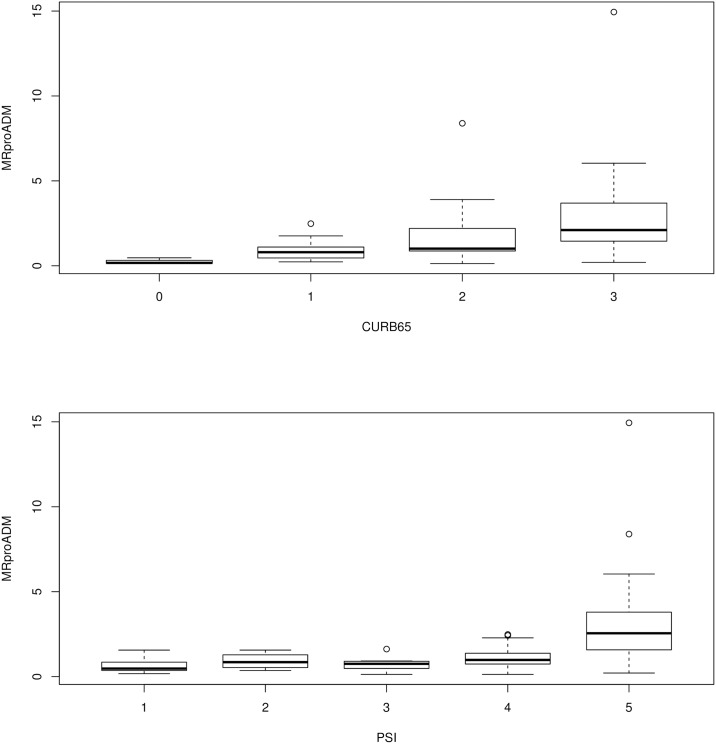
The distribution for MR-pro-ADM values within classes of clinical severity scores.Upper panel: MR-pro-ADM distribution within CURB65 classes: statistically significant differences in MR-pro-AMD concentrations were found between CURB65 group 0 and 1 (p = 0.046); between CURB65 group 0 and 2 (p = 0.013); and between CURB65 group 0 and 3 (p = 0.0108). Lower panel; MR-pro-ADM distribution within classes PSI: statistically significant differences in MR-pro-AMD concentrations were found between PSI class 5 and 1 (p = 0.020), and between PSI class 5 and 3 (p = 0.044).